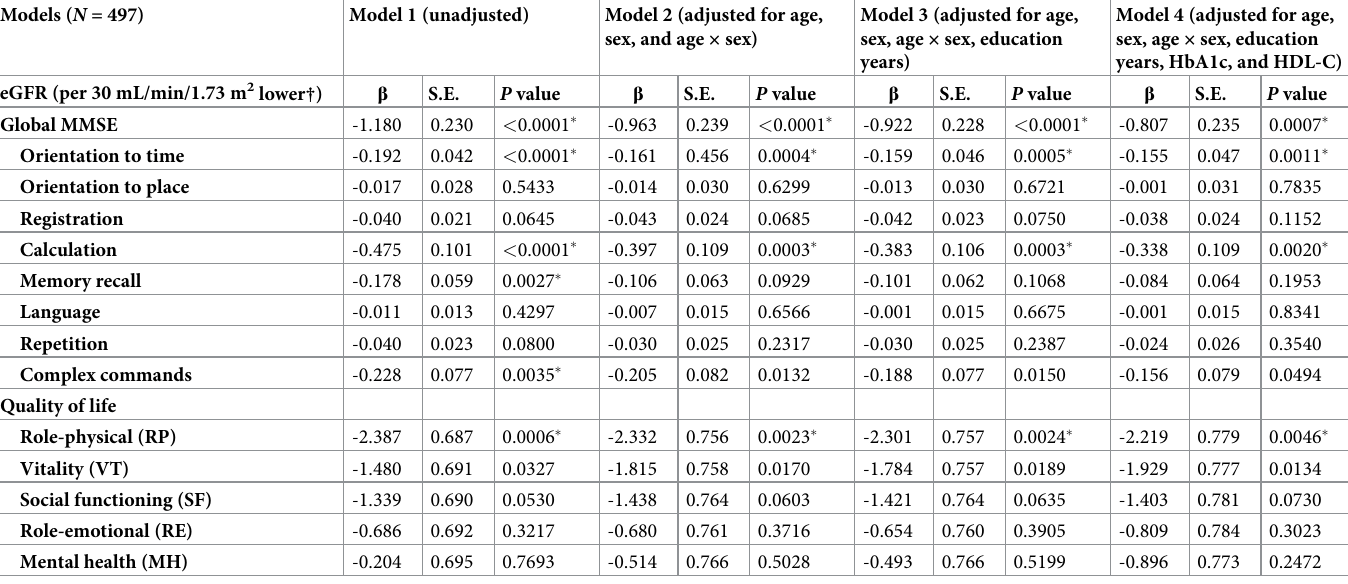
Table 4. Comparison of different models for the relationship among eGFR estimates, MMSE, and quality of life.